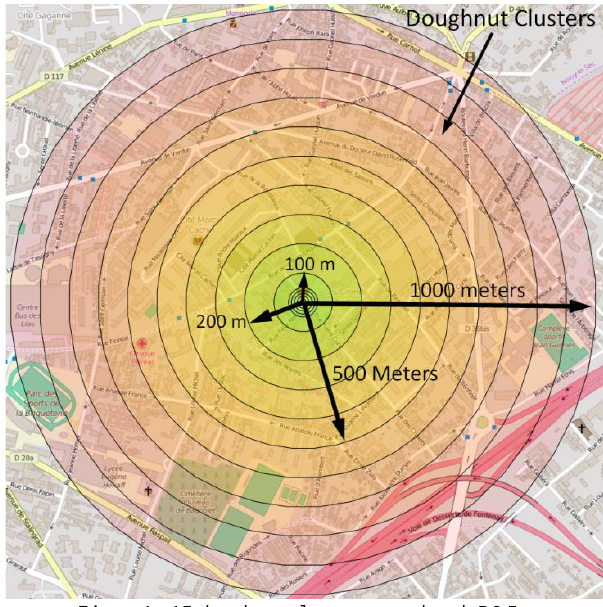
Figure 1. 15 doughnut clusters around each